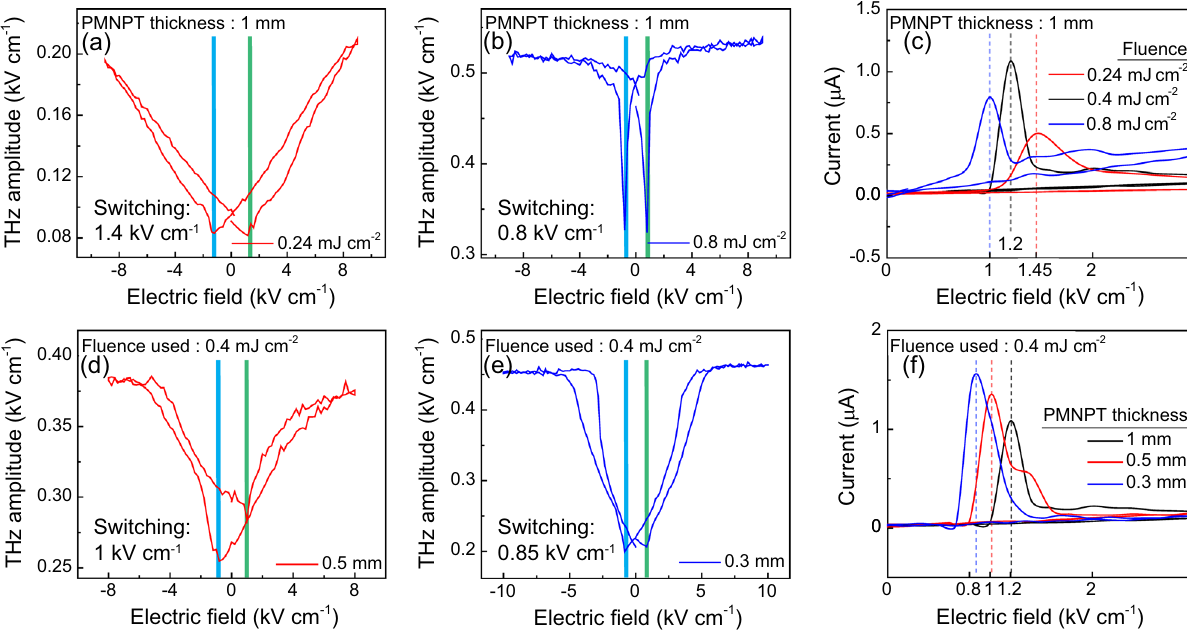
Fig. 2 Electric fi eld control of emitted THz amplitude with varying laser fl uence and PMNPT thicknesses, at H = 0 Oe . a , b THz-E hysteresis recorded with PMNPT thickness of 1 mm at a laser fl uence of a 0.24 mJ cm − 2 b 0.8 mJ cm − 2 c I-V characteristic highlights the quenching in electric fi eld coercivity with increasing laser fl uences as seen through decreasing peak positions d , e THz-E hysteresis recorded at an applied laser fl uence of 0.4 mJ cm − 2 with PMNPT thickness of d 0.5 mm e 0.3 mm. f Decrease in the leakage current peak positions with decreasing PMNPT thicknesses shows quenching in electric fi eld coercivity. The I-V characteristic of the emitter with 1 mm thick PMNPT substrate and pump fl uence of 0.4 mJ cm − 2 is adapted from Fig.